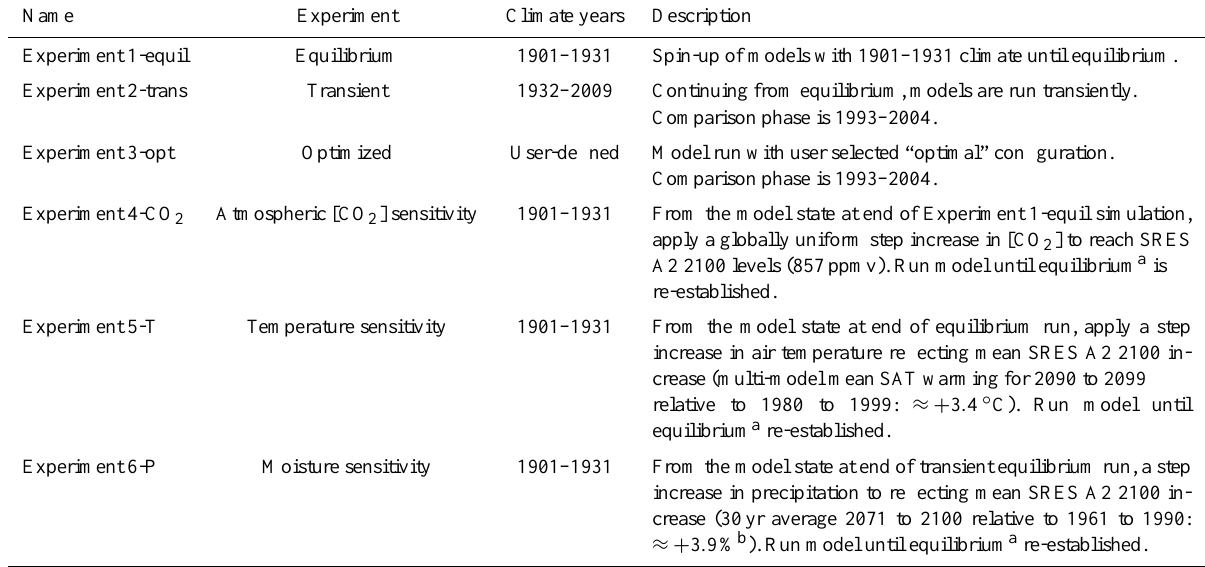
Table 1. Description of the WETCHIMP modelling